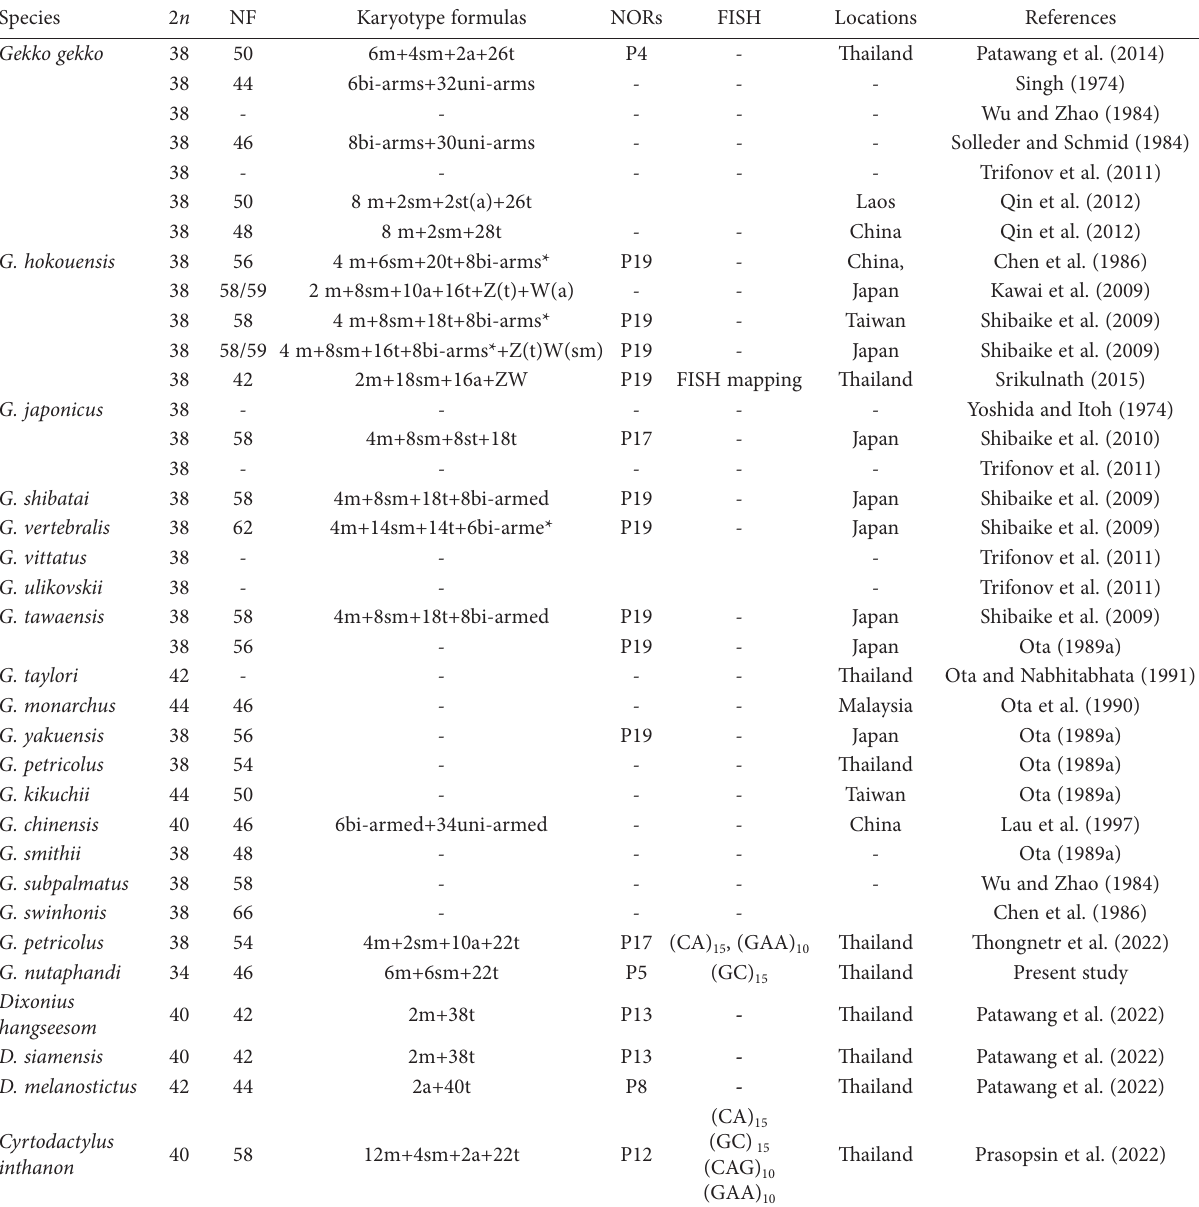
Table 1. The karyotype reviews among the genes Gekko (Gekkonidae, Squamata). Species 2 n